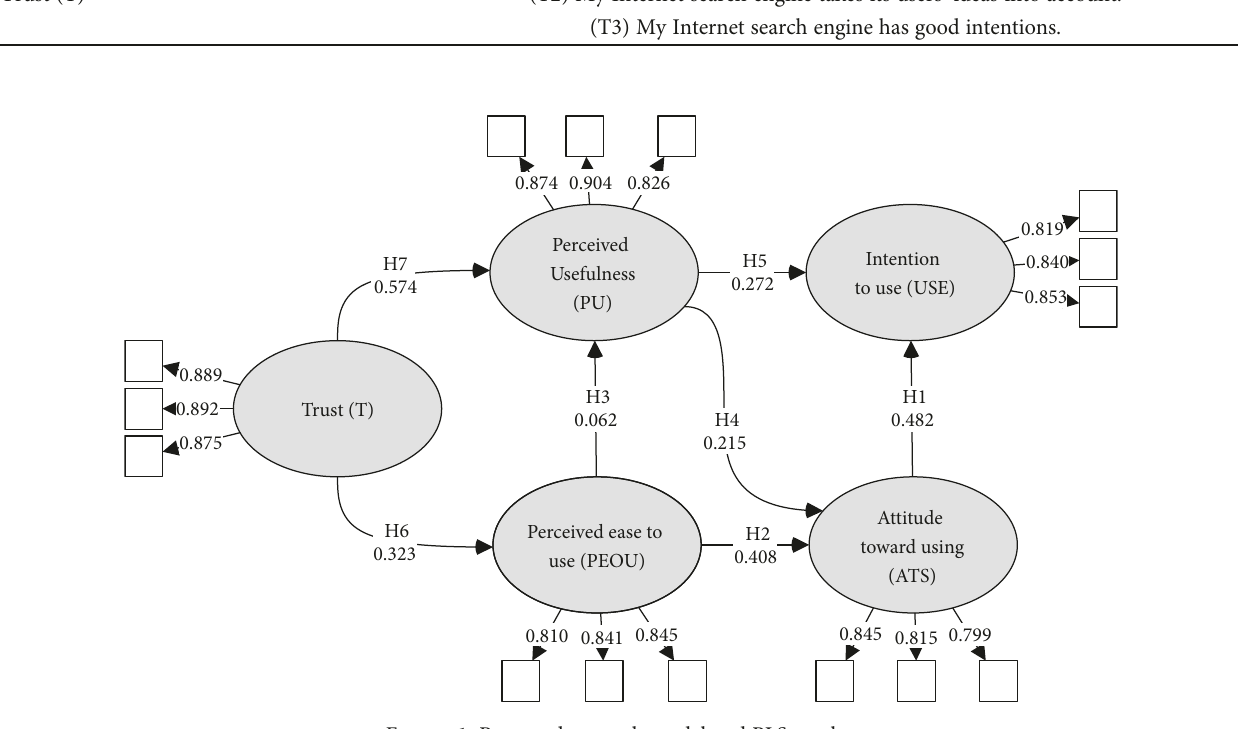
Figure 1: Proposed research model and PLS